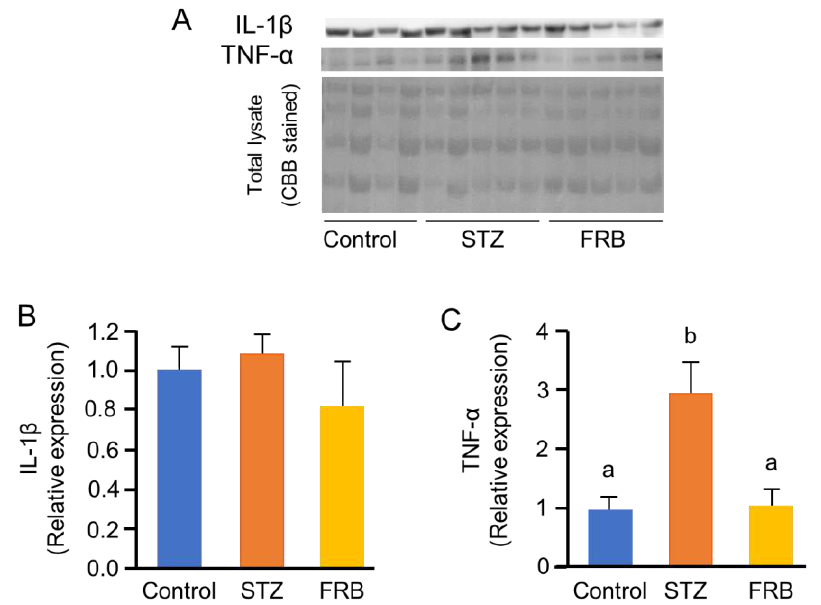
Figure 7. FRB decreased the expression of inflammatory cytokines. Representative blots of ( A ) IL-1 β and TNF- α , and quantification of ( B ) IL-1 β and ( C ) TNF- α . Data are shown as the means + SEM. Significance ( p < 0.05, n = 4 – 5) among groups is denoted by different letters (a, b).